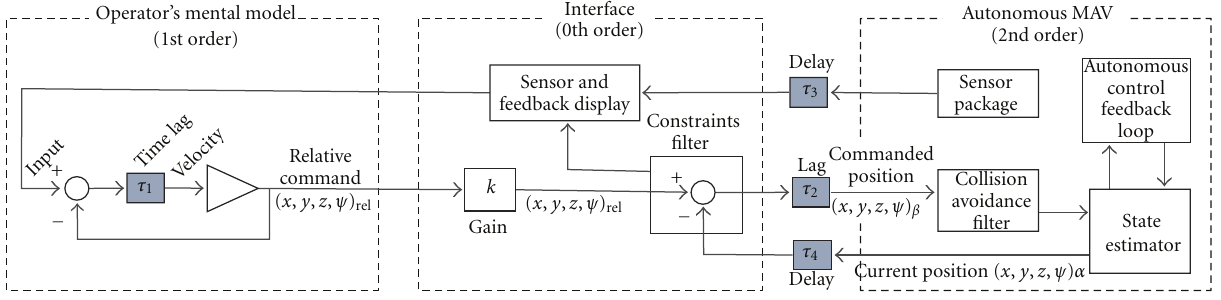
Figure 5: Diagram of perceived first-order control. Delays and lags are represented by τ , gains represented by k